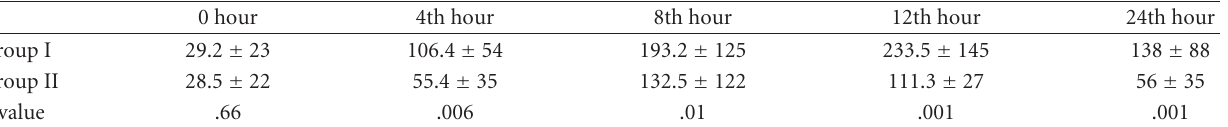
Table 3: CK-MB (U/L) levels of the patients in the groups during the first 24 hours.